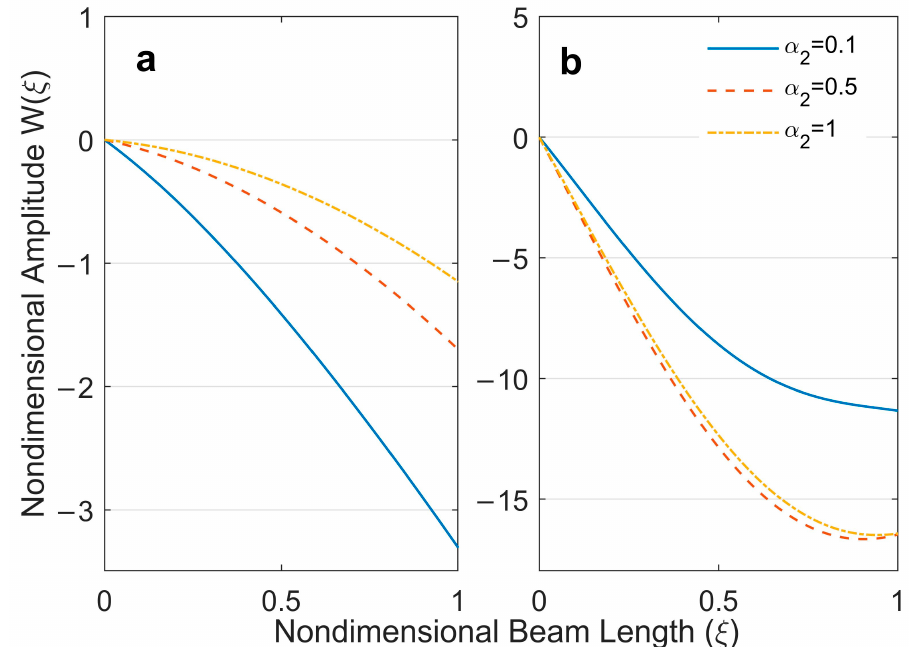
Figure 3. First and second mode shapes of the clamped–free beam with various α 2 values: ( a ) first mode shape, ( b ) second mode shape.